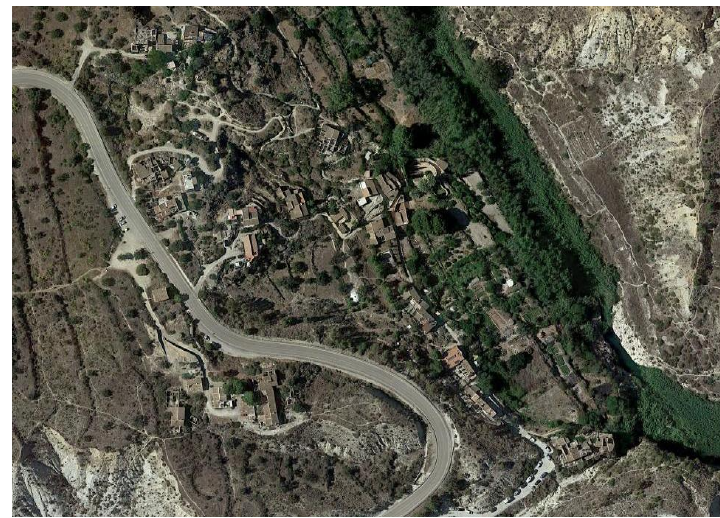
Figure 2. LMRA satelite